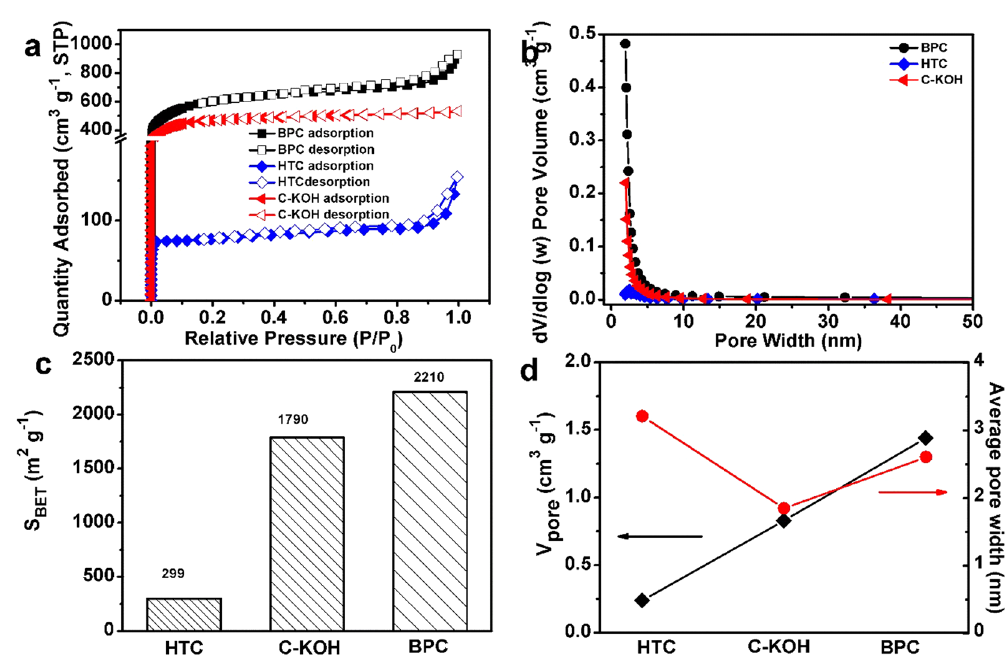
Figure 3. ( a ) Nitrogen adsorption-desorption isotherms. ( b ) Pore size distributions. ( c ) Pore volumes and average pore widths, and ( d ) BET surface areas of HTC, C-KOH, and